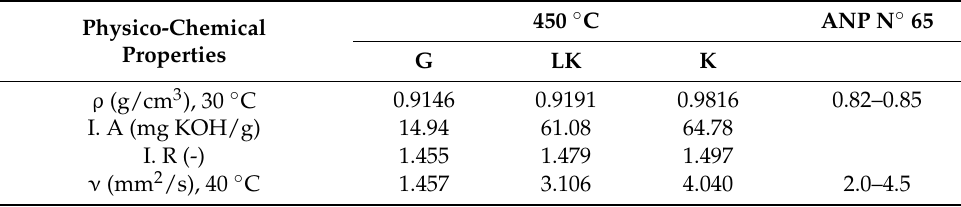
Table 6. Physico-chemical properties of distillation fractions of bio-oil produced by pyrolysis of Aça í seeds at 450 ◦ C and 1.0 atmosphere, in pilot